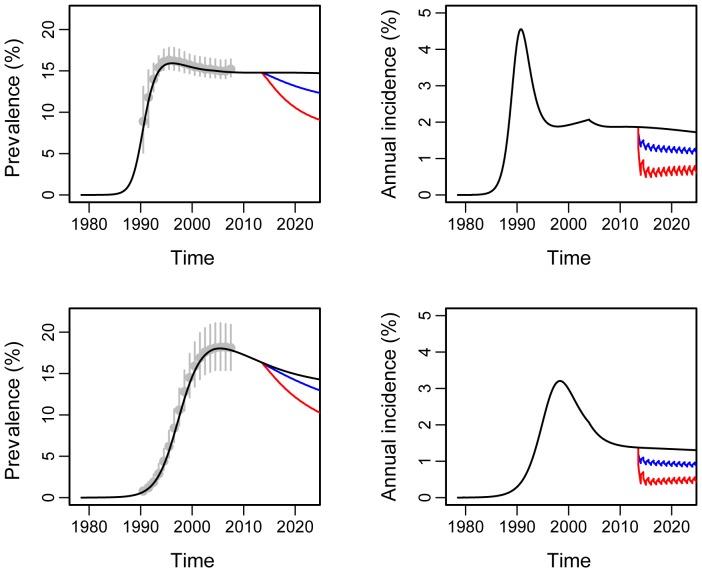
Model fit and projections under central target scenario for Zambia (top row) and South Africa (bottom row).Left panels show HIV prevalence and right panels show annualized HIV incidence over time. The red, blue and black lines correspond to arms A, B and C respectively. The grey dots and error bars are the UNAIDS HIV prevalence estimates [37].